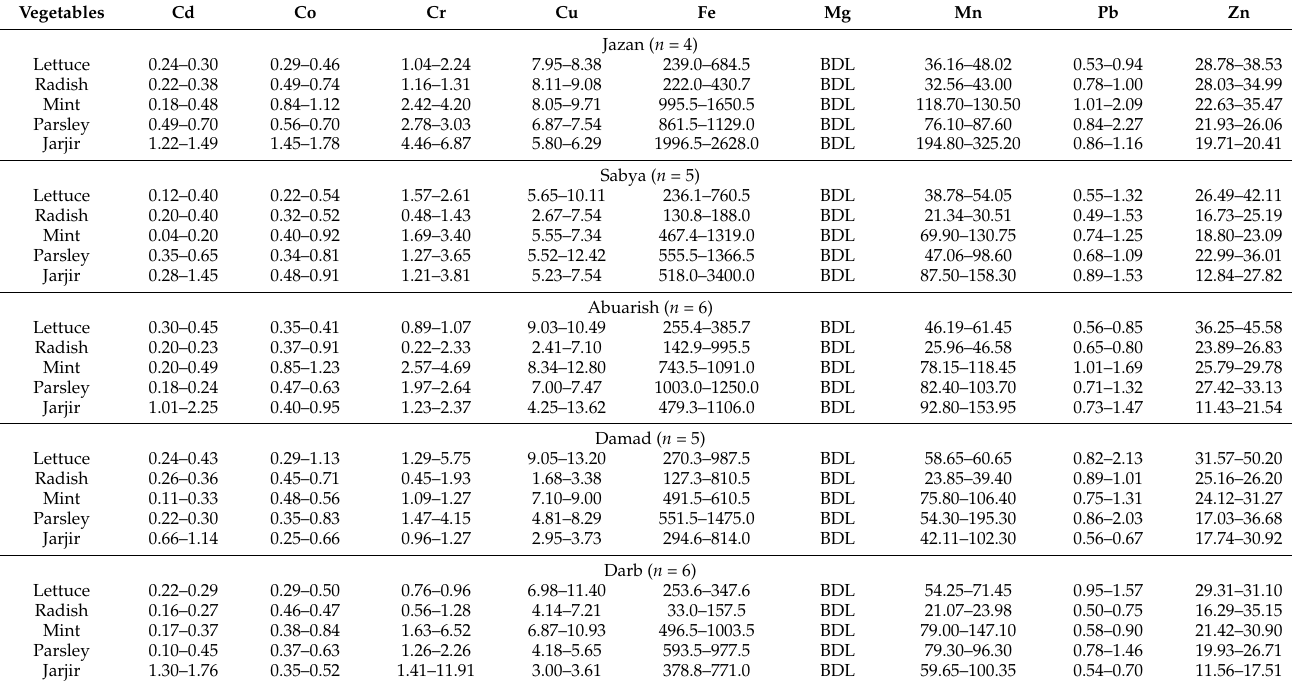
Table 2. Heavy metal concentrations (mg/kg, on dry weight basis) in leafy vegetables grown in the Jazan region, Saudi